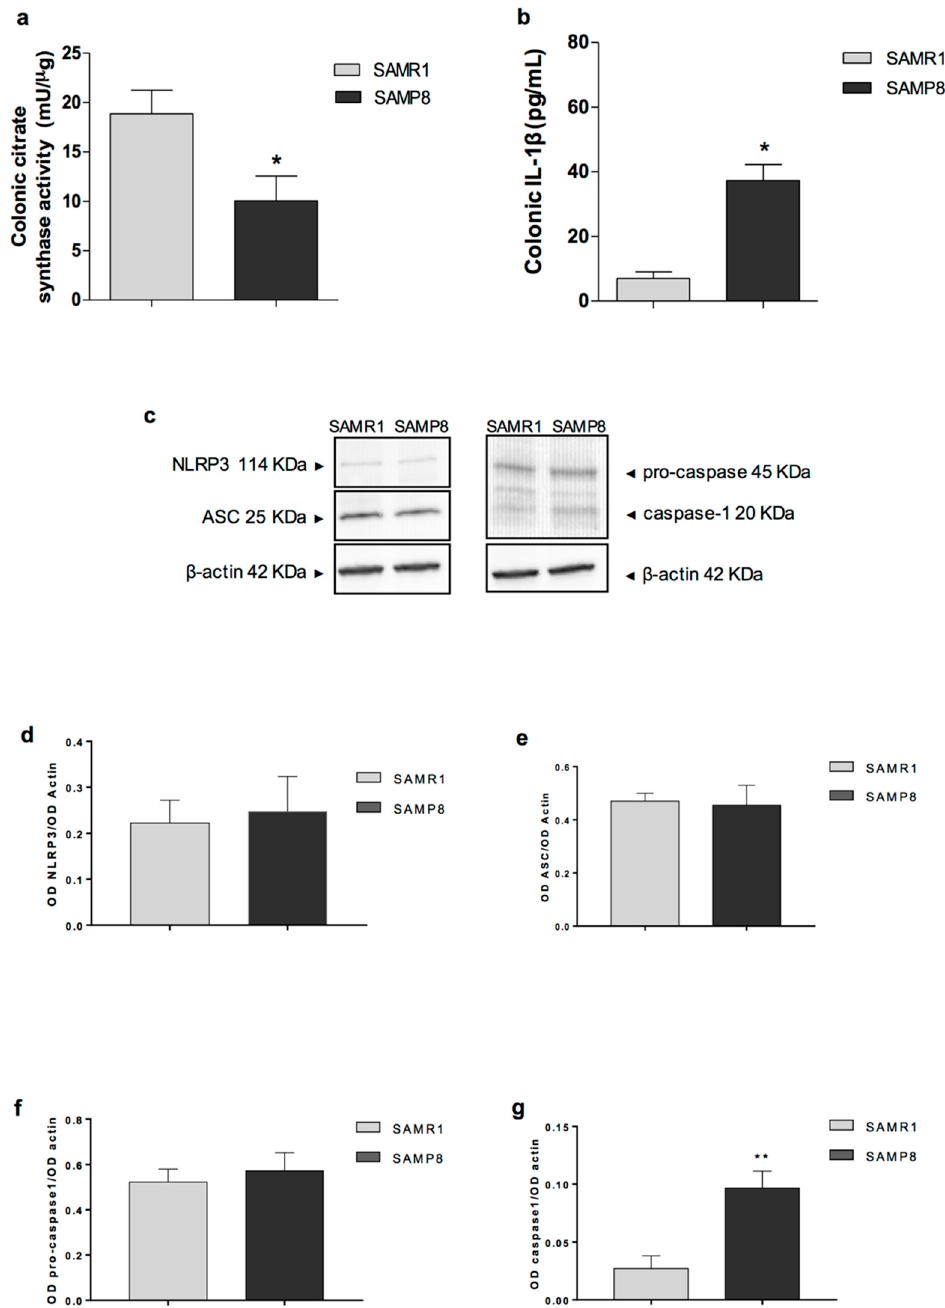
Figure 4. Mitochondrial activity and inflammation in colonic specimens: ( a ) citrate synthase in colonic tissues from SAMR1 and SAMP8 animals at six months of age; ( b ) IL-1 β levels in colonic tissues from SAMR1 and SAMP8 animals at six months of age; ( c ) representative immunoblot from four mice per group; and ( d – g ) densitometry of Western blot results for NLRP3, ASC, pro-caspase-1 and cleaved caspase-1 in SAMR1 and SAMP8 mice. Expression was normalised against β -actin. Data are expressed as mean ± S.E.M. from eight animals. * p < 0.05, ** p < 0.01, significant differences versus age-matched